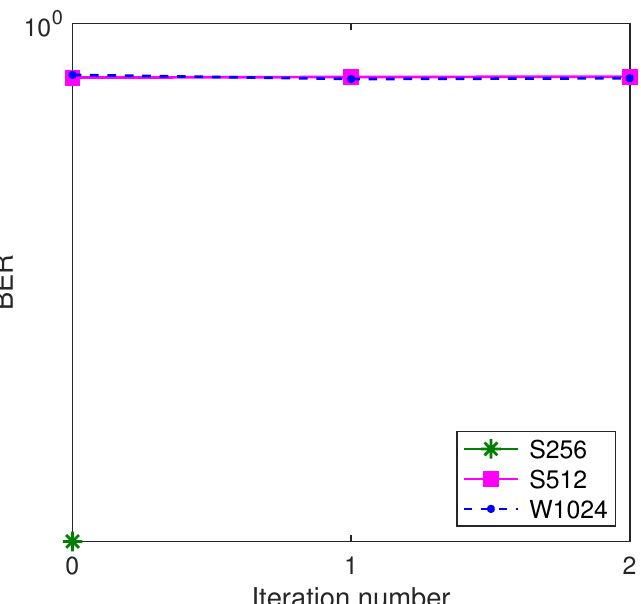
Figure 14. BER performance of the GL turbo system with rate-1/16 convolutional code for Yellow Sea 1.